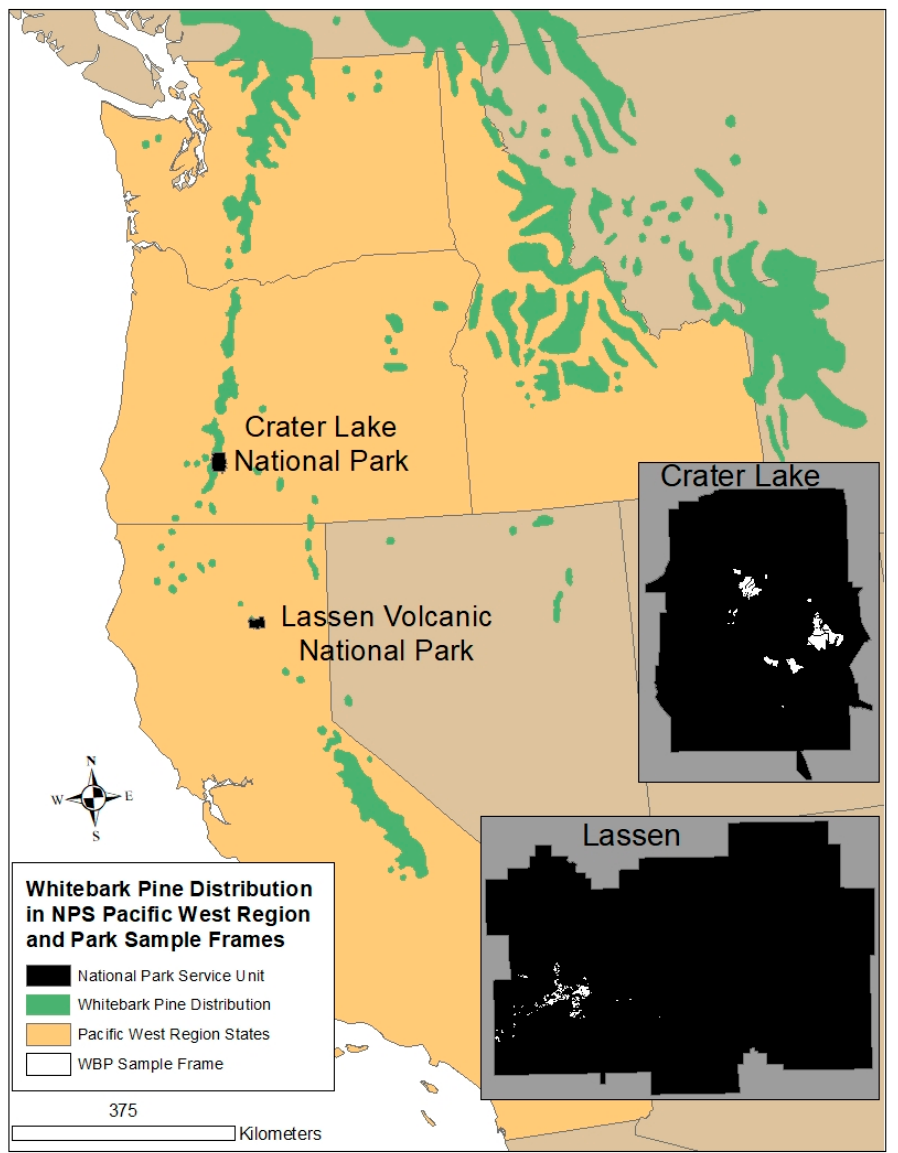
Figure 1. Whitebark pine distribution in the western United States, states within the National Park Service Pacific West Region, and location of Crater Lake National Park and Lassen Volcanic National Park Inset maps show the whitebark pine sampling frames from Crater Lake National Park and Lassen Volcanic National